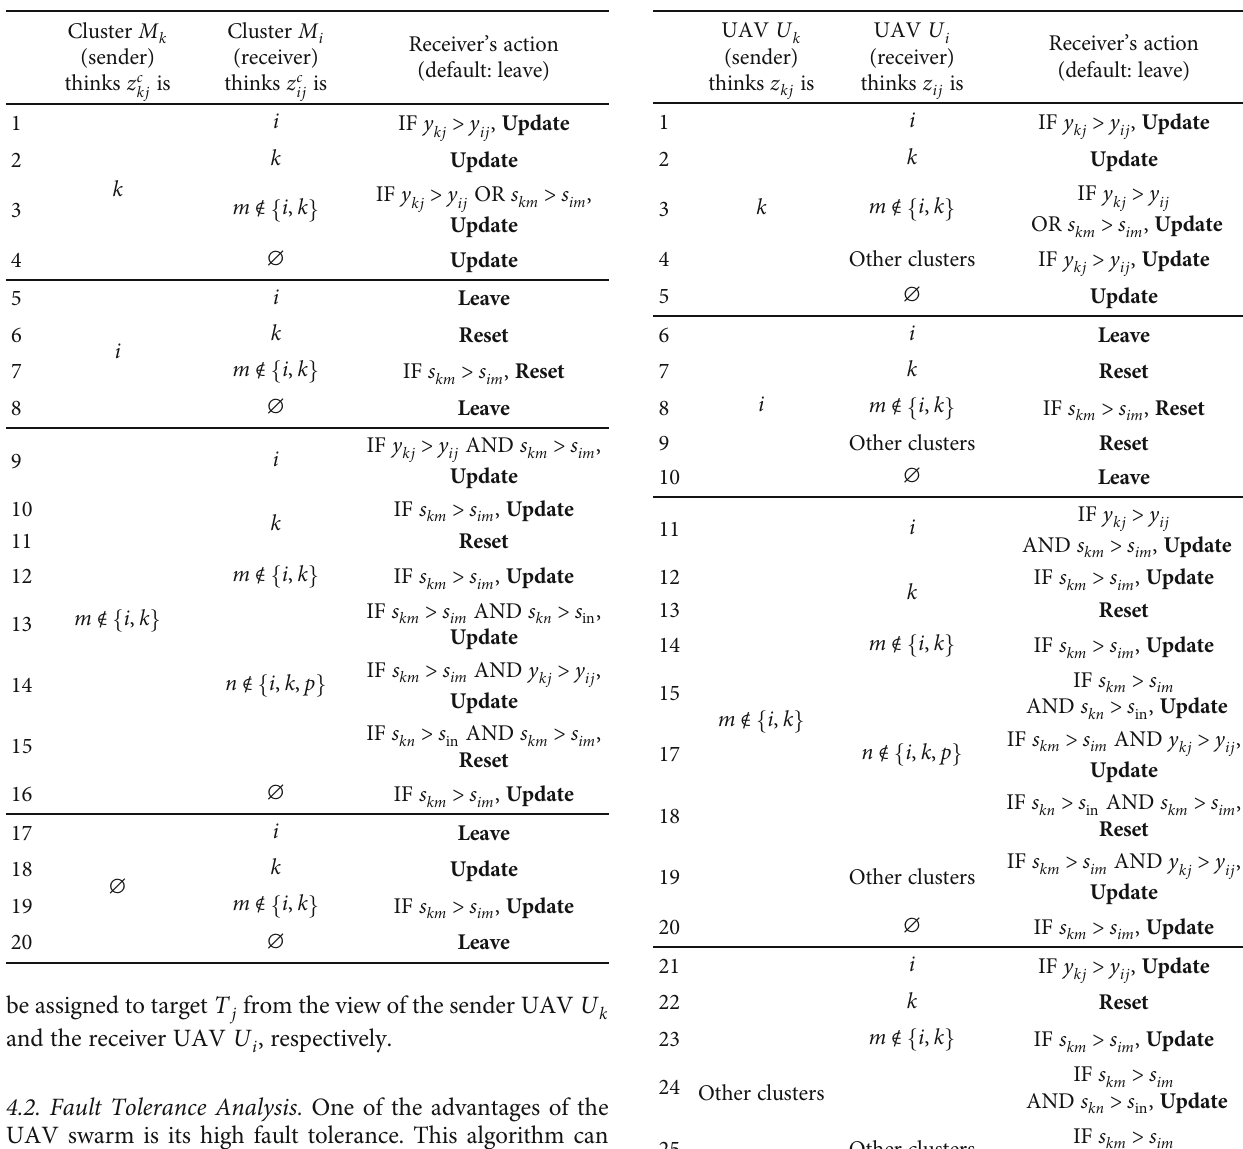
Table 1: The consensus rules between UAV clusters. Table 2: The consensus rules between UAVs within a UAV